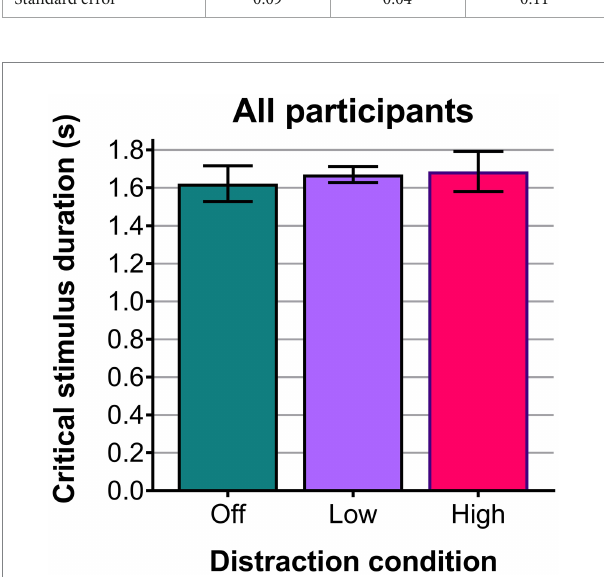
FIGURE 8 Plot of the mean critical stimulus durations (seconds) across all 12 participants for the three distraction conditions. Error bars show the standard